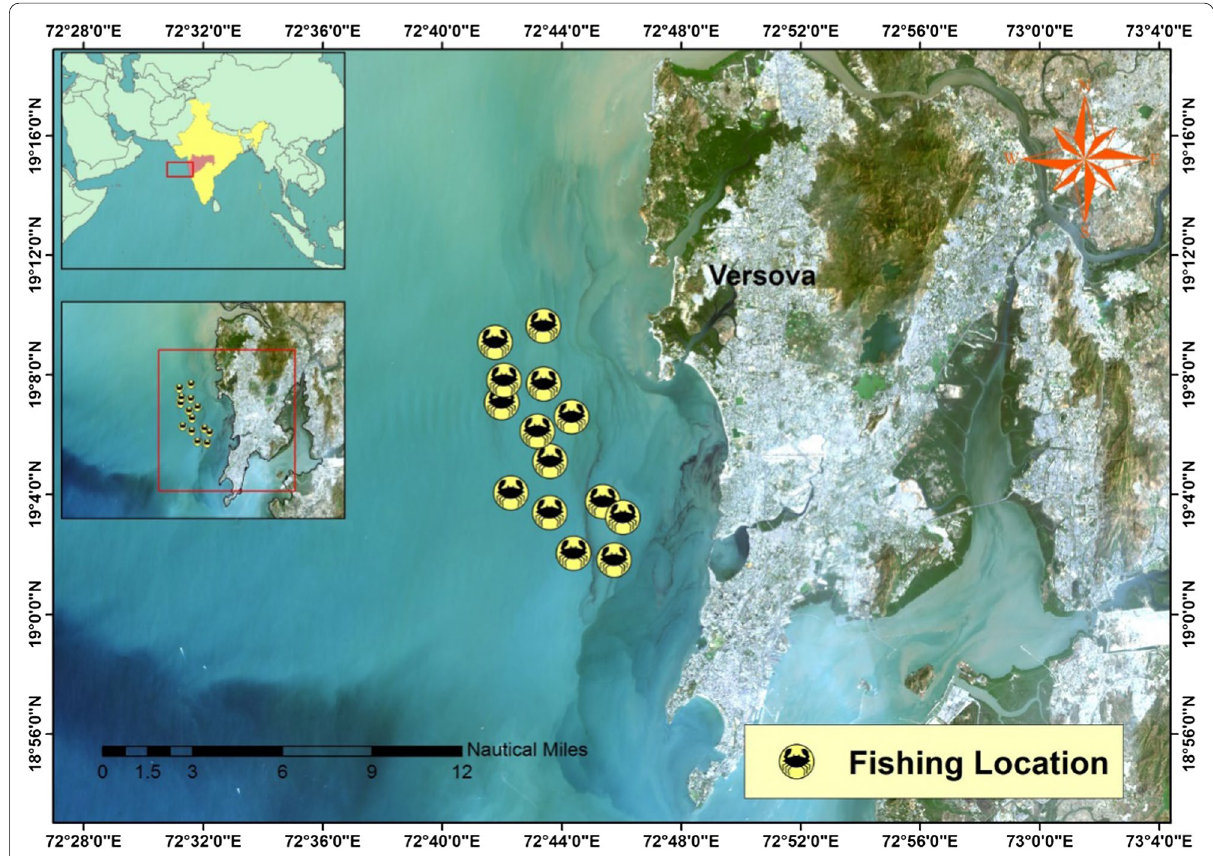
Fig. 1 Map showing the experimental trawling locations along Mumbai coast,